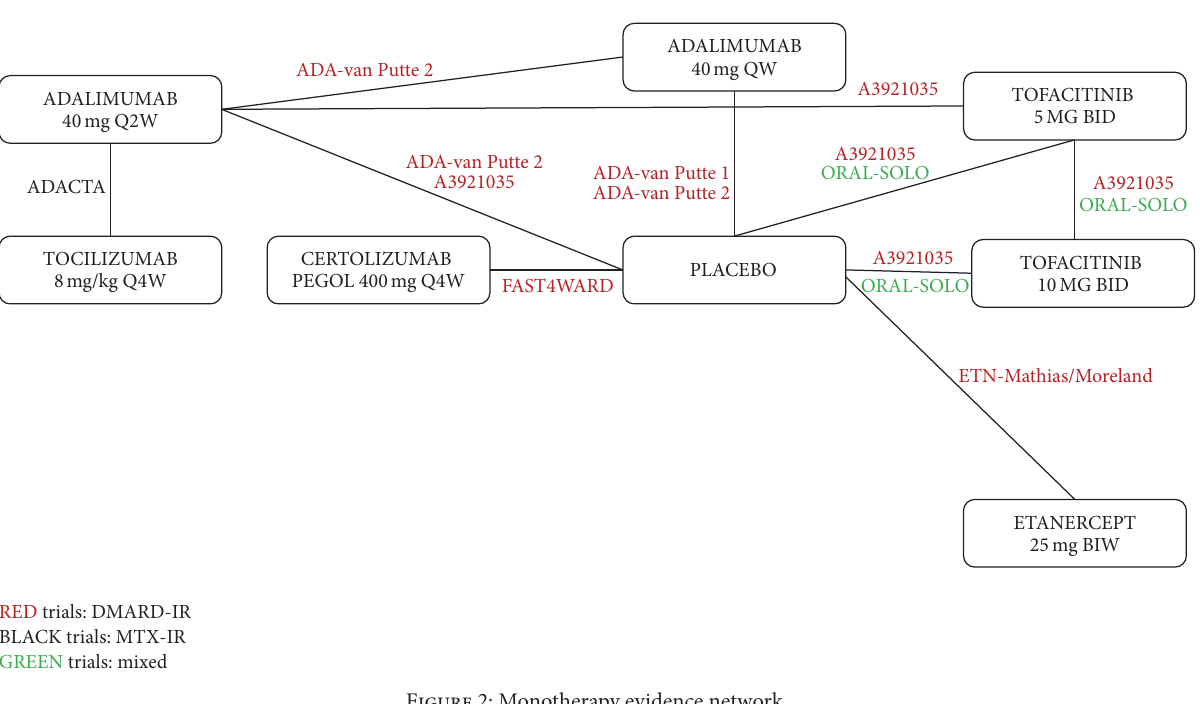
Figure 2: Monotherapy evidence